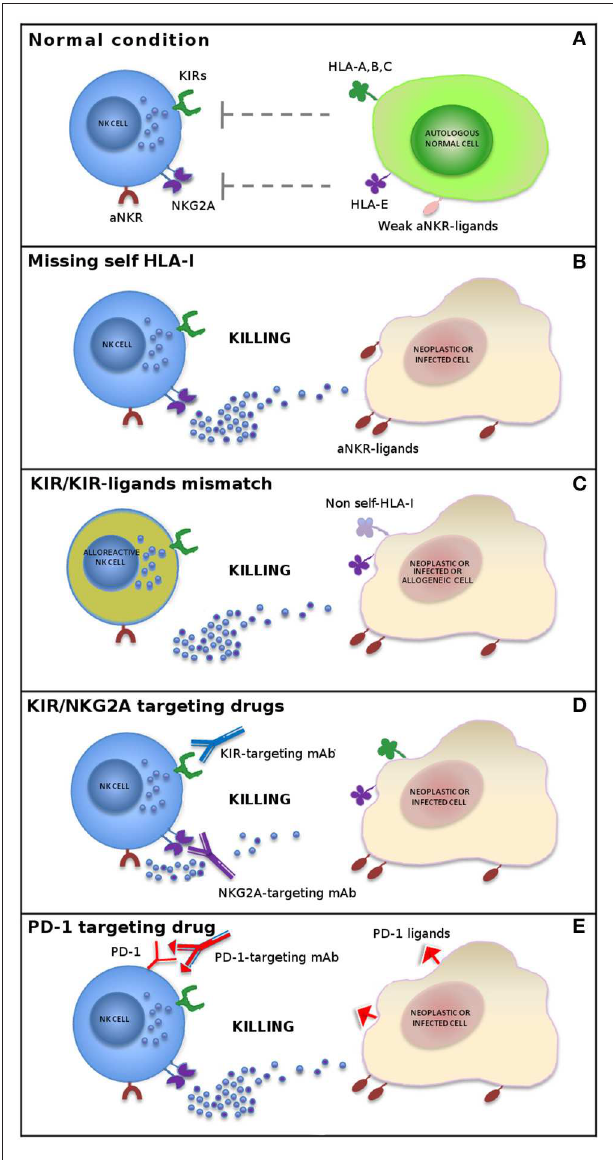
FIGURE 1 | Mechanisms of NK cell-mediated killing. In physiological conditions, NK cell activity is tightly regulated by a complex interplay between inhibitory and activating receptors that prevents killing of normal autologous cells expressing an appropriate level of all self-HLA alleles and low/negative levels of ligands for non-HLA-specific activating receptors (aNKR) (A) . Downregulation of HLA-I molecules on neoplastic or infected cells induces NK-mediated killing by a “missing-self” recognition mechanism. NK cell activating receptors are co-responsible in inducing NK cell triggering by interacting with ligands (aNKR-ligands) overexpressed or expressed de novo on tumor-transformed or virus-infected cells (B) . Allogeneic (alloreactive) donor NK cells are able to kill neoplastic cells of the recipient expressing non-self allotypic determinants on HLA-I molecules (“KIR/KIR-ligand mismatch”) and to control infections with a limited risk of toxicity (e.g., GvHD and HvG) (C) . The use of inhibitors of classical NK cell immune checkpoints (i.e., KIR and NKG2A) (D) or immune checkpoints shared with T cells (e.g., PD-1) (E) or, finally, a combination of these approaches represents new promising strategies in NK cell-based